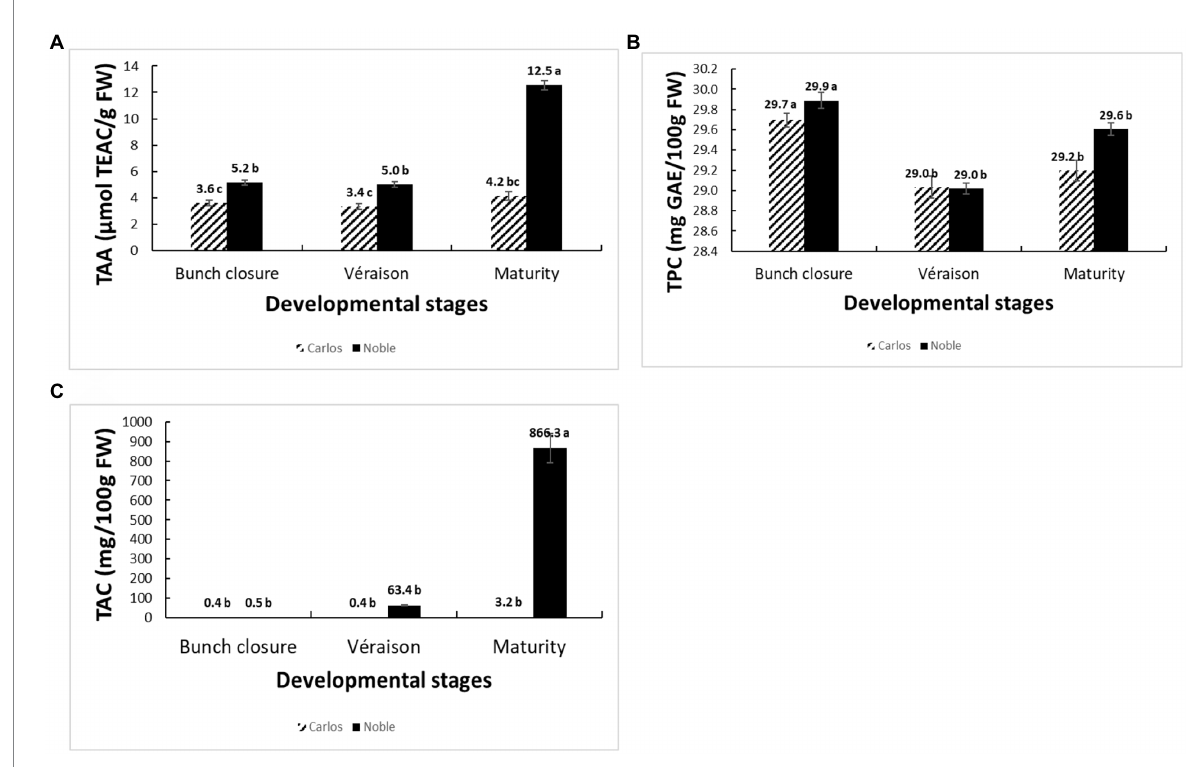
FIGURE 2 Physiological and biochemical changes of muscadine grapes cv. “Carlos” and “Noble” during grape berry ripening. The developmental stages include bunch closure, veraison, and maturity. (A) Total antioxidant activity (TAA) was measured by the ferric reducing antioxidant power (FRAP) assay. (B) Total phenolic content (TPC) was measured by the modified colorimetric Folin–Ciocalteu method with slight modification. (C) Total anthocyanin content (TAC) was measured by the pH-differential method. The experiments were carried out in four biological replicates, and each replicate was repeated three times. The different lowercase letters represented significant differences among the developmental stages of an individual cultivar, according to the Glimmix procedure in SAS 9.4 ( p >